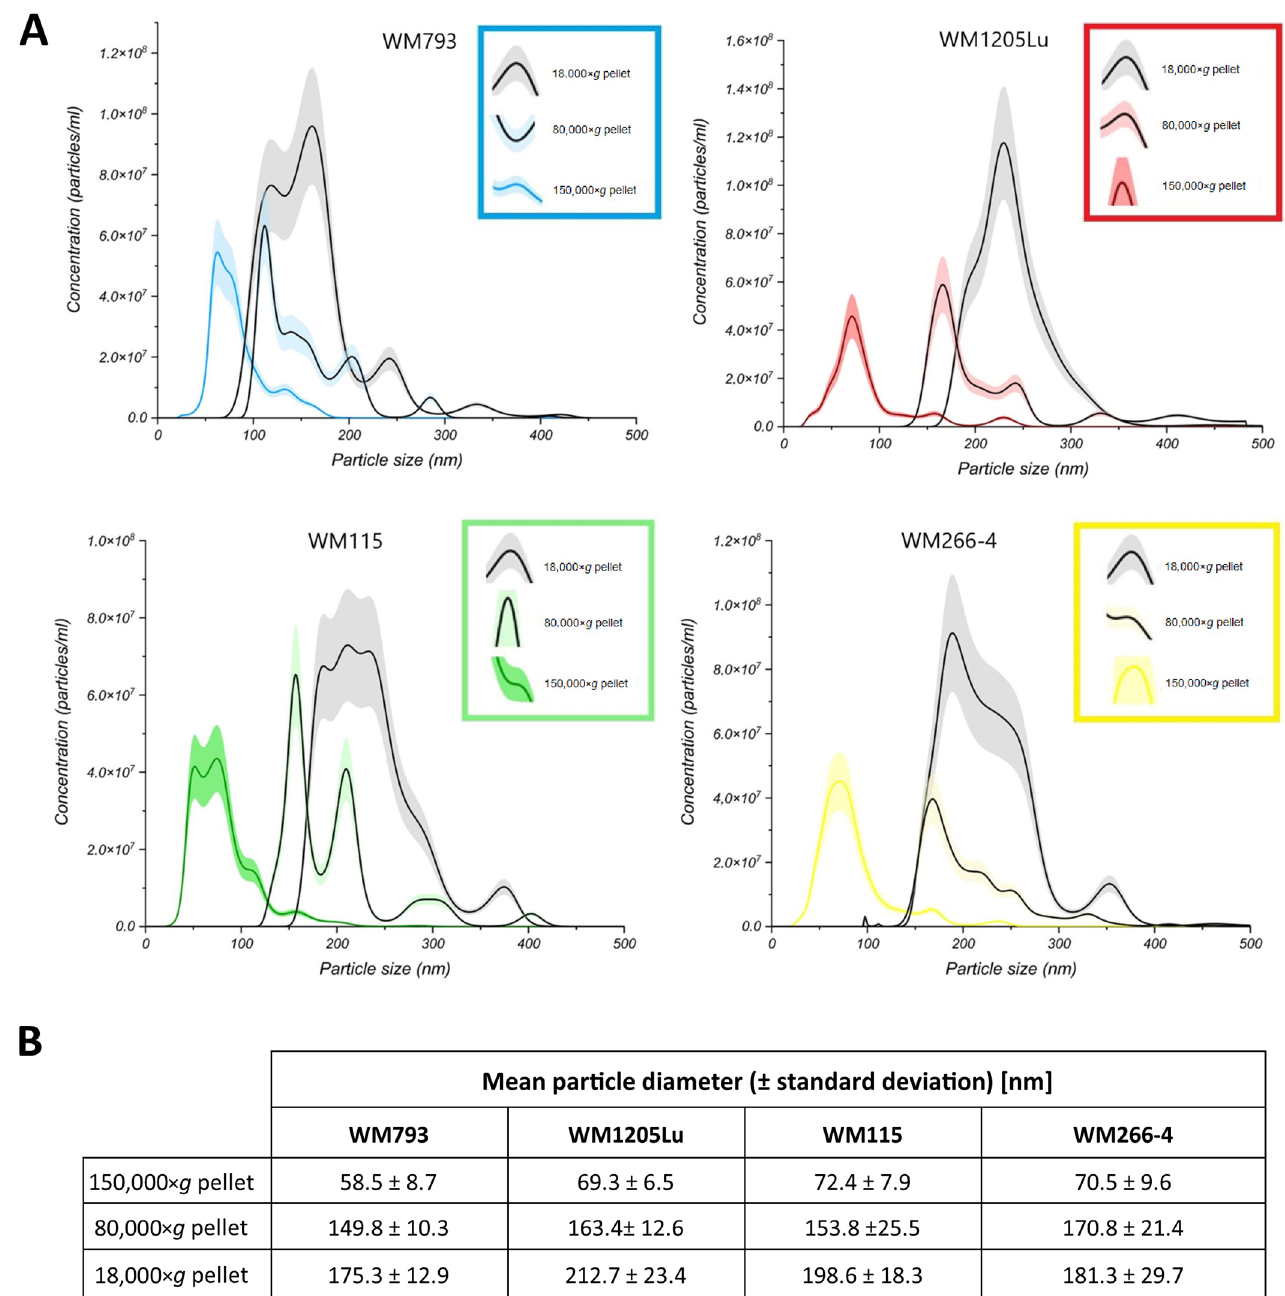
Figure 1. Nanoparticle tracking analysis (NTA) of pellets obtained during exosome isolation, i.e., intermediate centrifugation steps (18,000 × g and 80,000 × g ), and of final 150,000 × g pellet (exosomes). ( A ) The graphs show means from five independent measurements with ± standard deviation (shaded area). ( B ) Mean particle diameter ± standard deviation measured for all pellets were also presented in table. (WM115/WM266-4,WM793/WM1205Lu—isogenic pairs (primary/metastatic) of CM cell lines that were used for exosome isolation.